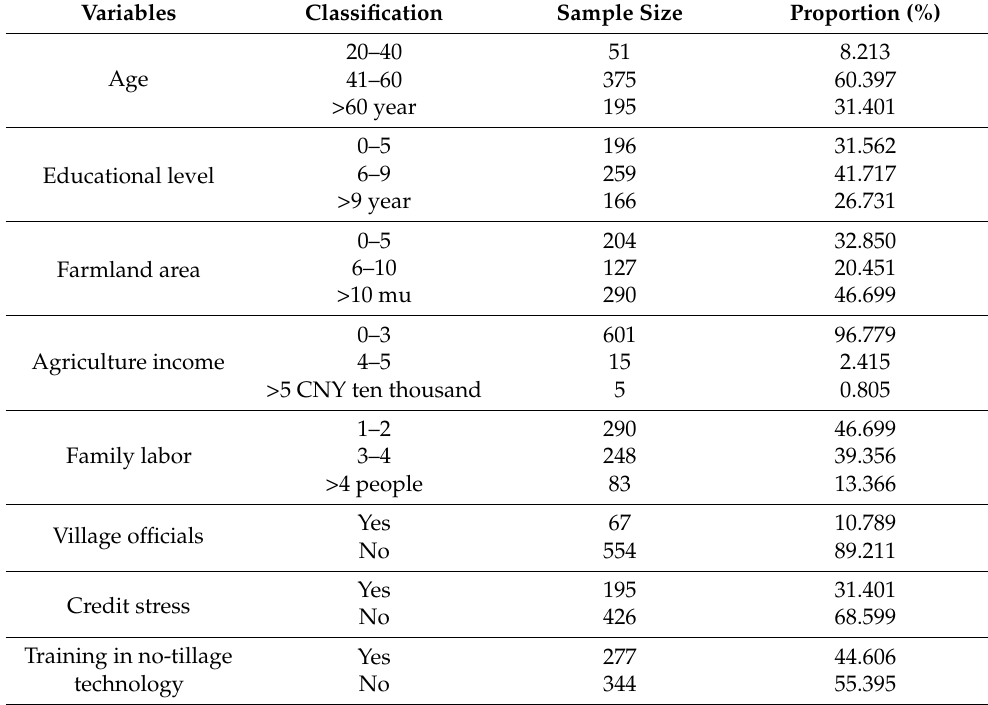
Table 1. Descriptive statistics of individual characteristics.